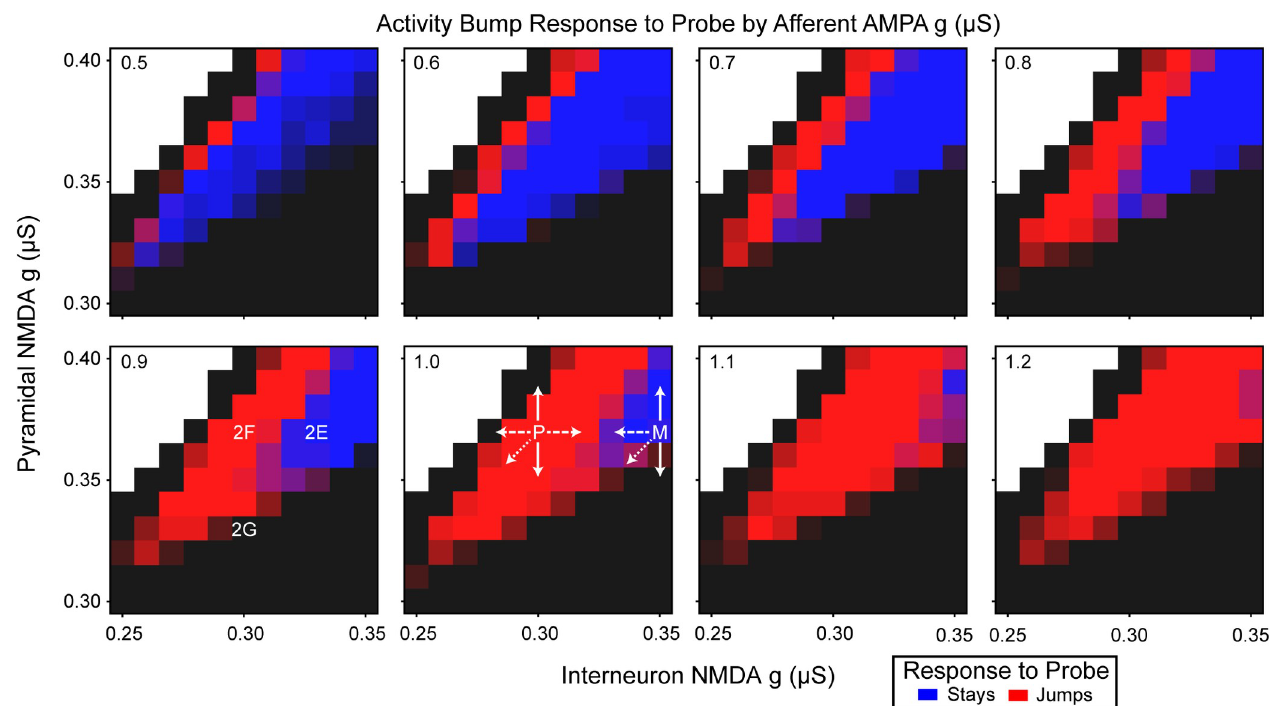
Fig 3. Activity bump response to the probe as a function of excitation, inhibition, and afferent signal. The afferent AMPA conductance (g) is indicated in the top left of each panel. The degree of blueness indicates the percentage of trials in which the activity bump maintained the cue representation, and redness indicates the percentage of trials in which the activity bump jumped to the probe representation. The black and white regions indicate excitation-inhibition balances that were incapable of maintaining representation of the cue, albeit for different reasons. The degree of blackness indicates the percentage of trials in which the activity bump collapsed prior to the probe or that the cue representation was never initiated, and white indicates the parameter region in which the pyramidal cell firing was epileptic (i.e., showed an extremely high firing rate across the entire population that does not represent information). The P and M in the 1.0 AMPA conductance panel are the locations of the context-integration agent’s perception and memory networks (Fig 4A) within NMDA conductance parameter space. The arrows coming from these indicate various manipulations that were performed to these networks. The solid line is pyramidal cell NMDA conductance manipulation, the dashed line is interneuron NMDA conductance manipulation, and the dotted line is manipulation of both.